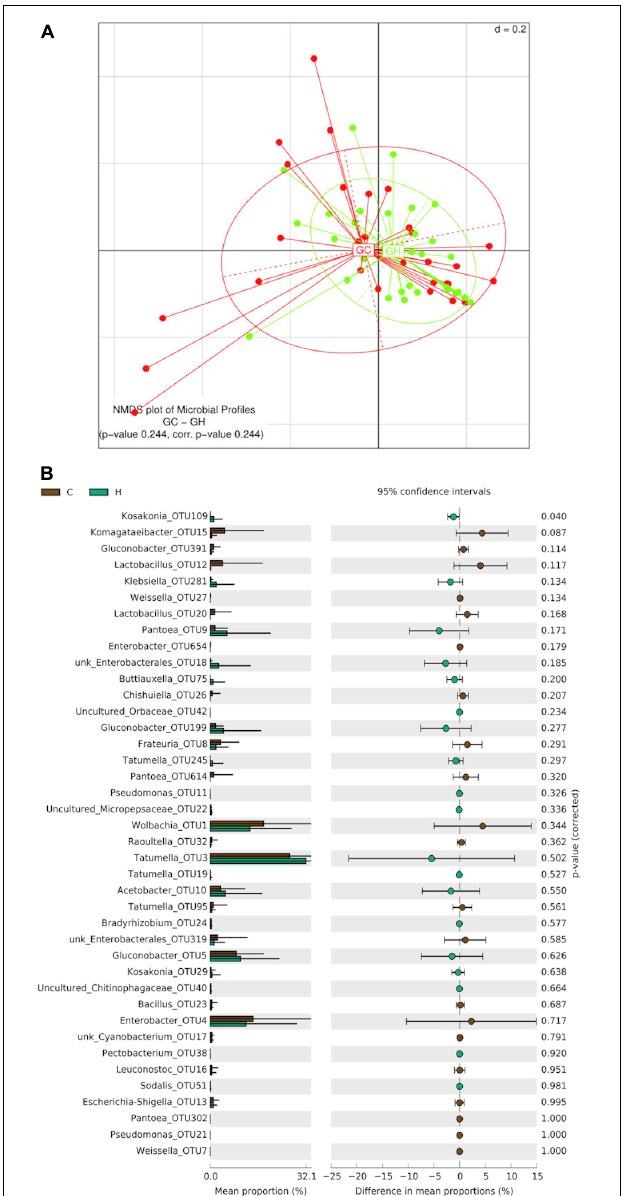
FIGURE 7 | Effect of geographic origin on the larval gut bacteriome of wild Anastrepha fraterculus sampled in peaches. (A) Meta Non-metric Multidimensional scaling (meta NMDS) plot representing sample groups according to the area where fruit was collected: C (Concordia, Entre Ríos) or H (Horco Molle, Tucumán). Significant p -value from PERMANOVA analysis; d = 0.2. (B) Origin effect on OTUs relative abundance mean: the plot presents the mean proportion of reads for each OTU to the left (bars show mean value and standard error) the difference in mean proportions for each pair of comparisons (as well as its associated p -value according to Welch’s T